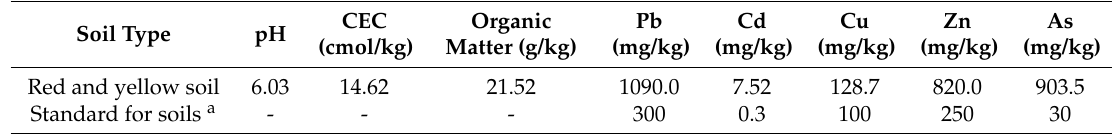
Table 1. Basic properties of the farmland soil under study (d.w.).